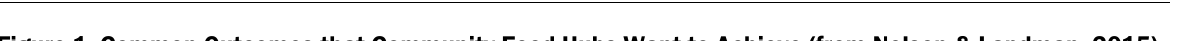
Figure 1. Common Outcomes that Community Food Hubs Want to Achieve (from Nelson & Landman,